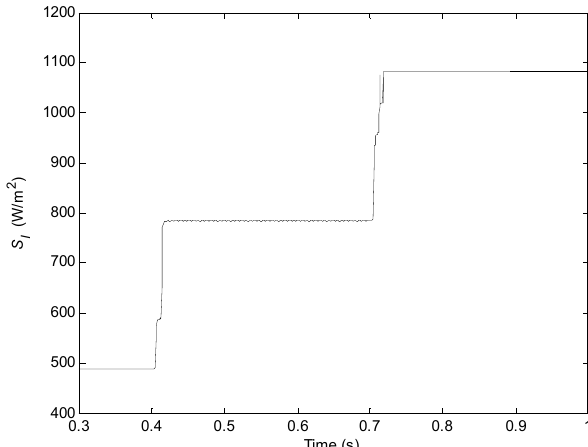
Figure 21. Curve in second simulation.